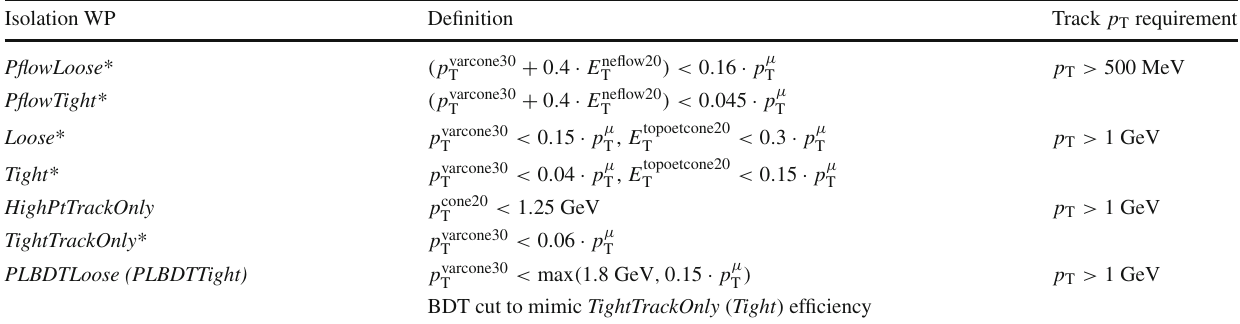
Table 2 Definitions of the muon isolation WPs. The criteria used are listed in the second column, while the requirement on the minimum track p T is shown in the third column. WPs marked with * exist in